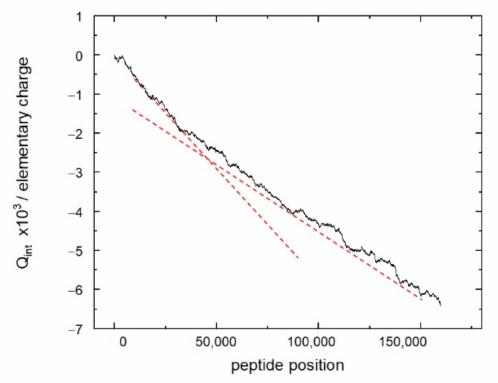
Figure 2. Integral charge of the resemblance-ranking peptide library depending on the interval of integration. Peptides are arranged according to their weight in the